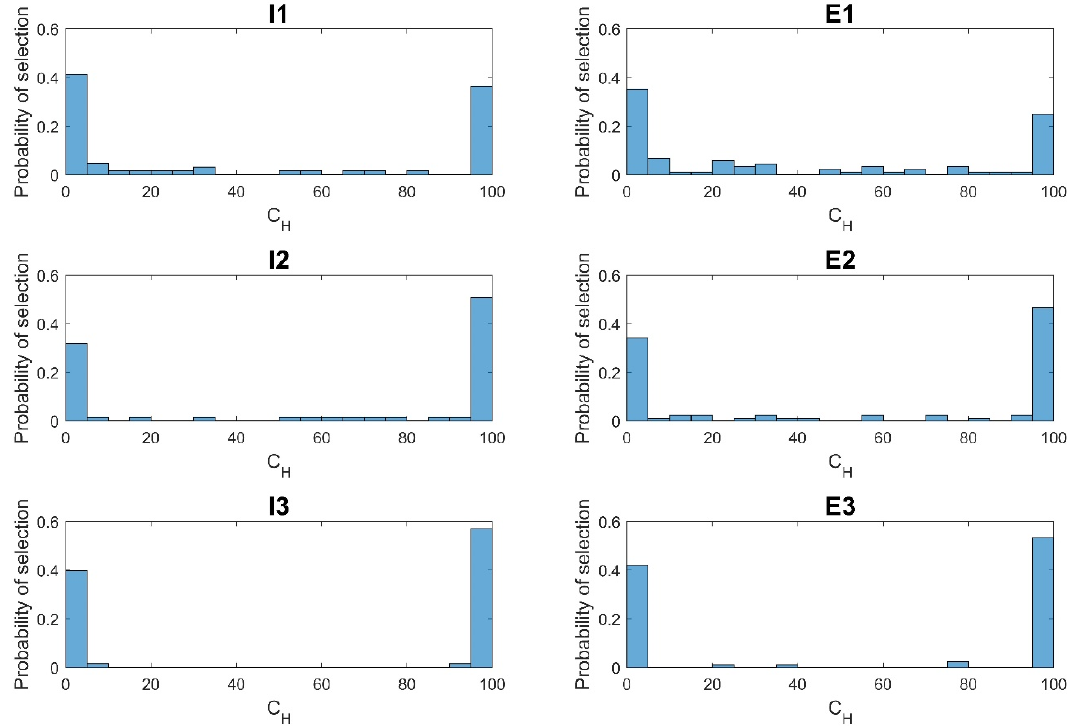
Figure 15. Probability of selection for C H values for multiple turbines grid layouts.